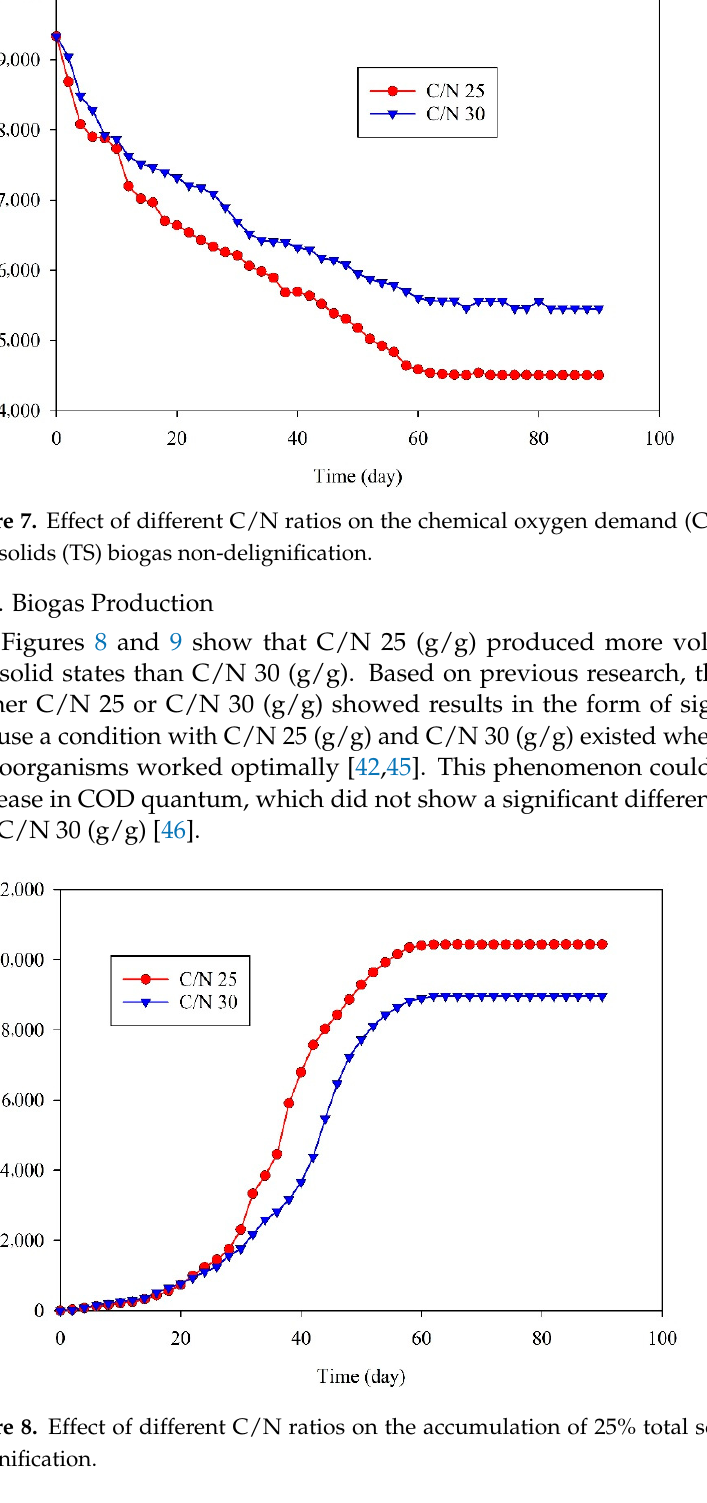
Figure 6. Effect of different C/N ratios on the chemical oxygen demand (COD) reduction of 20% total solids (TS) biogas with delignification.